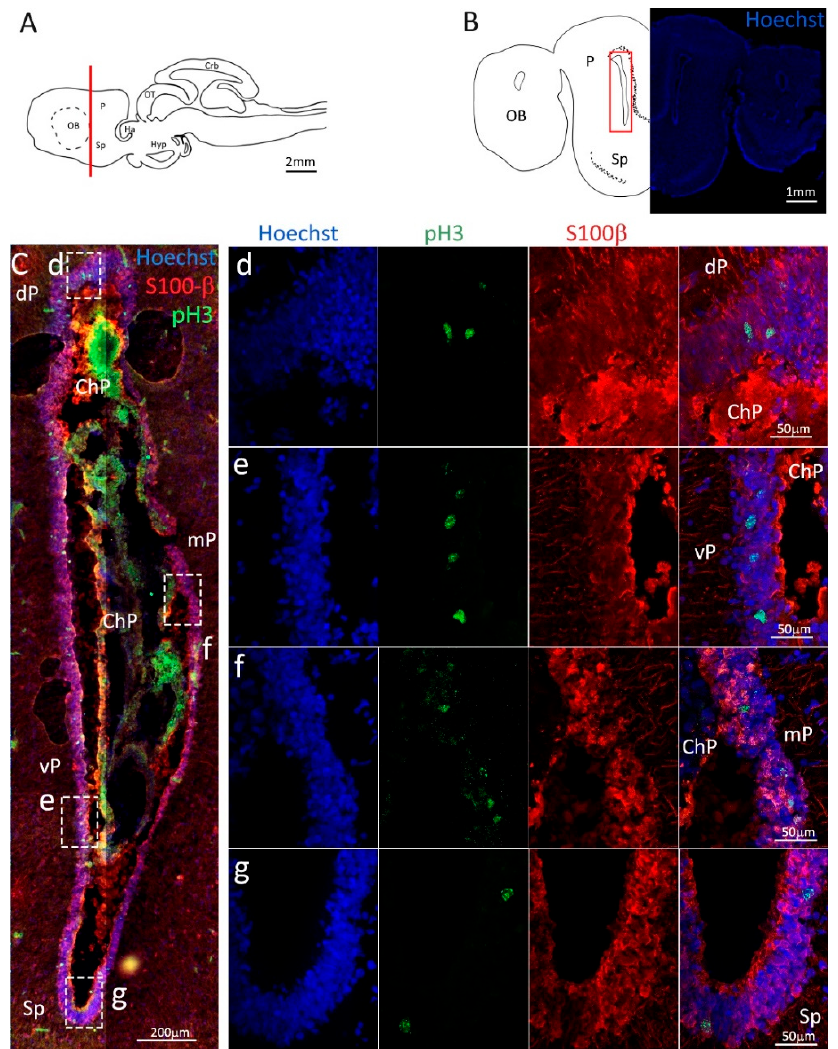
Figure 7. Localization of S100 β (red) and pH3 (green) positive cells in the posterior telencephalon of S. canicula . ( A ) Sagittal representation of S. canicula brain. The red line indicates the rostro-caudal localization of the section represented in the panel. ( B ) Coronal map of the posterior telencephalon. On the right, a real coronal section is stained with Hoechst 33342 to show nuclei distribution; on the left, a cartoon is drawn to indicate anatomical references. Red rectangle identifies the general area from which images are taken. ( C ) Actively dividing cells (pH3 + , green) in the posterior telencephalic neurogenic niche localize in the neurogenic niche (S100 β + , red). ( d ) Magnification of the neurogenic niche localized in the dP. ( e ) Magnification of the neurogenic niche localized in the dP. ( f ) Magnifica- tion of the neurogenic niche localized in the mP. ( g ) Magnification of the neurogenic niche localized in the Sp. Abbreviations: OB: olfactory bulb, P: pallium, Sp: subpallium, dP: dorsal pallium, mP: medial pallium, vP: ventral pallium, ChP: choroid